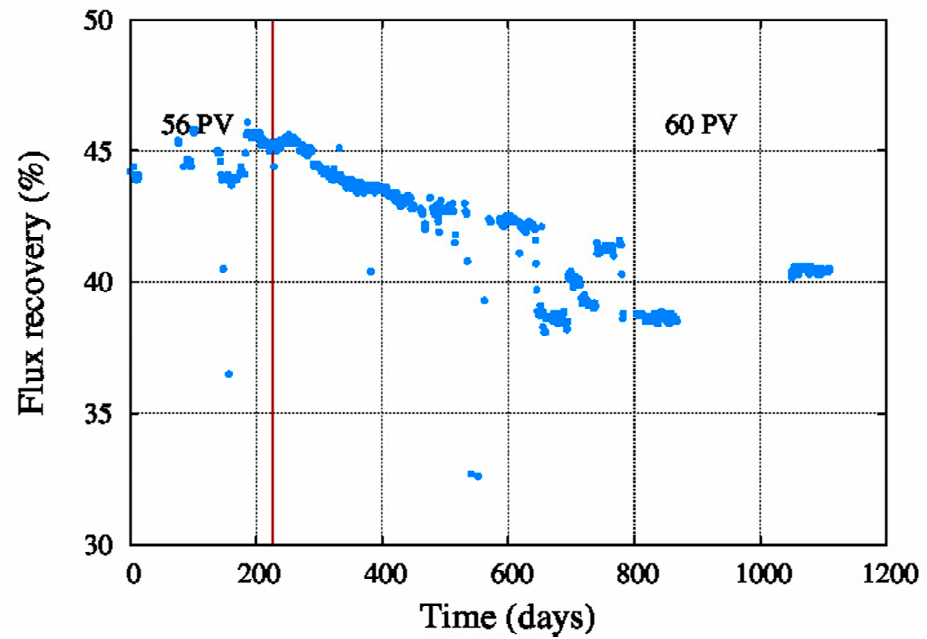
Figure 6. Figure 6. Recovery.